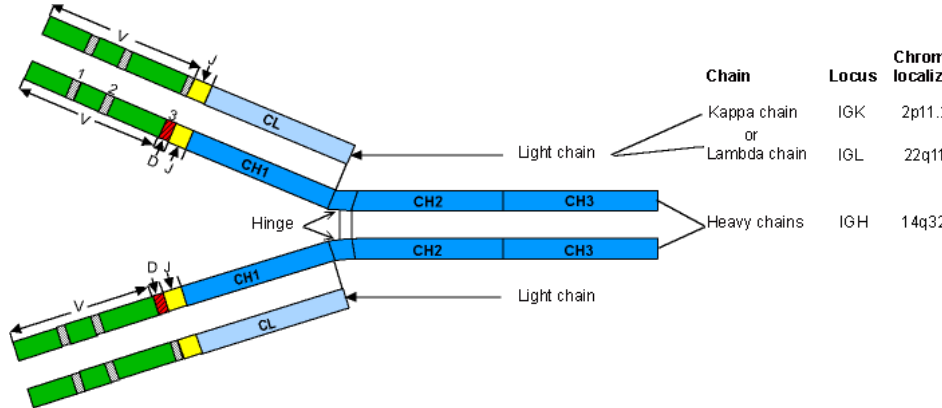
Figure 5. Schematic representation of an immunoglobulin [2]. The two inter heavy chain (inter ‐ H) disulfide bridges correspond to those of a human ( Homo sapiens ) IgG1. The intrachain (Cys 23 ‐ Cys 104) disulfide bridge of each of the 12 domains are not shown. The three complementarity regions (CDR1, CDR2 and CDR3) of the VH (V ‐ D ‐ J ‐ region) and of the VL (V ‐ J ‐ region) are indicated by hatches (and numbers 1, 2, 3 for VH). V = V ‐ REGION (in green), J = J ‐ REGION (in yellow), D = D ‐ REGION (or more exactly N ‐ AND ‐ D ‐ REGION to take into account the N ‐ diversity) (in red), the C ‐ REGION is in blue (dark blue for the heavy (H) chain, light blue for the light (L) chain). (With permission from M ‐